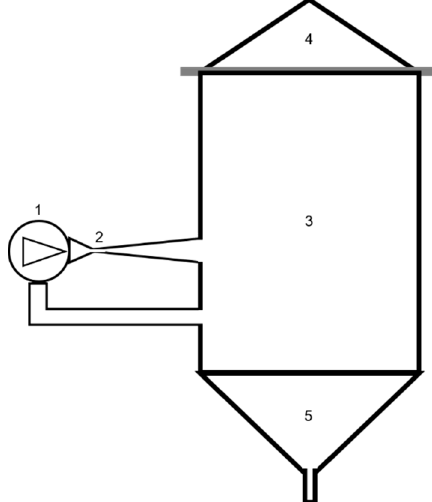
Figure 1. Experimental hydrodynamic cavitation (HC)-based installation. 1—centrifugal pump, 2—HC reactor, 3—main vessel, 4—cover, 5—discharge.